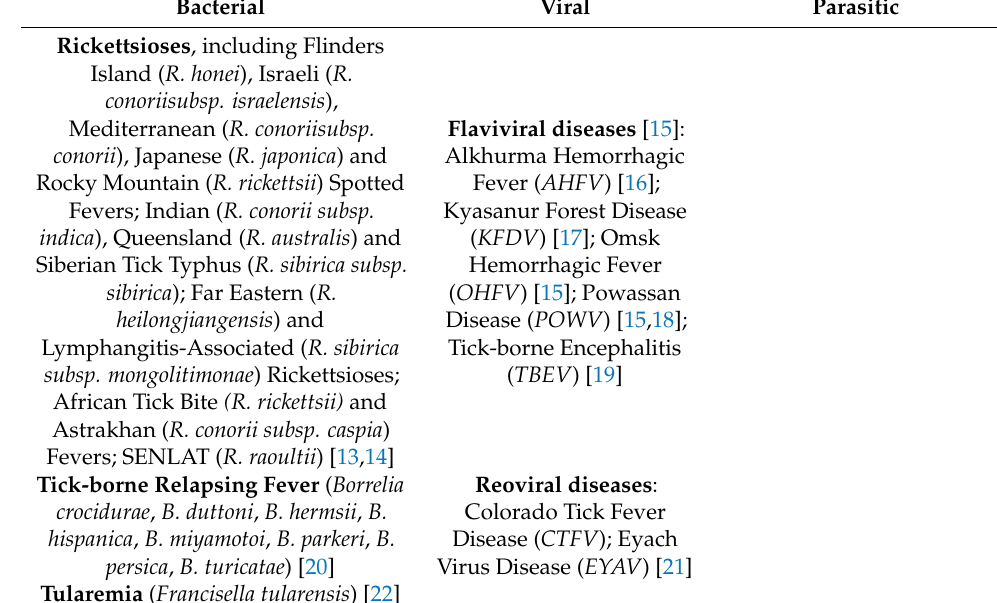
Table 1. Cont. Bacterial Viral Parasitic